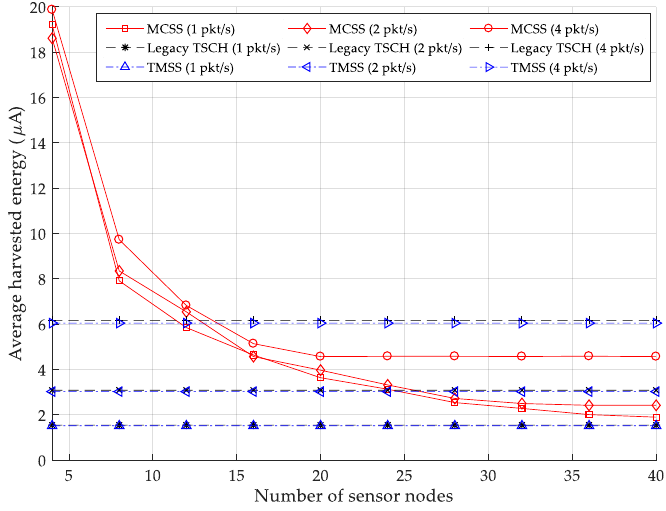
Figure 10. Average harvested energy.